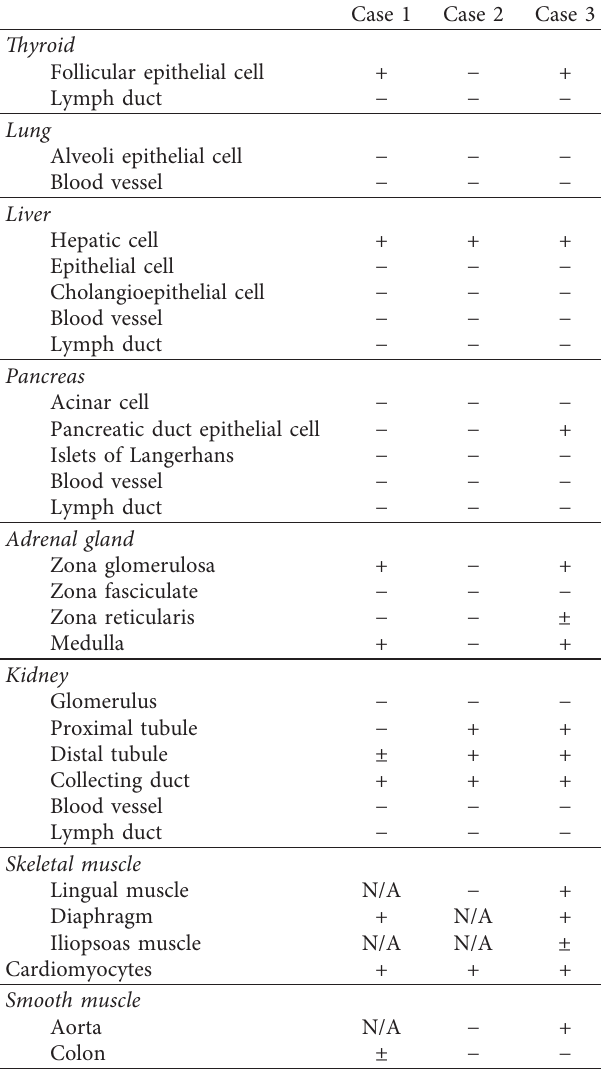
Table 2: Distribution of (pro)renin receptor expression in organs outside the brain.